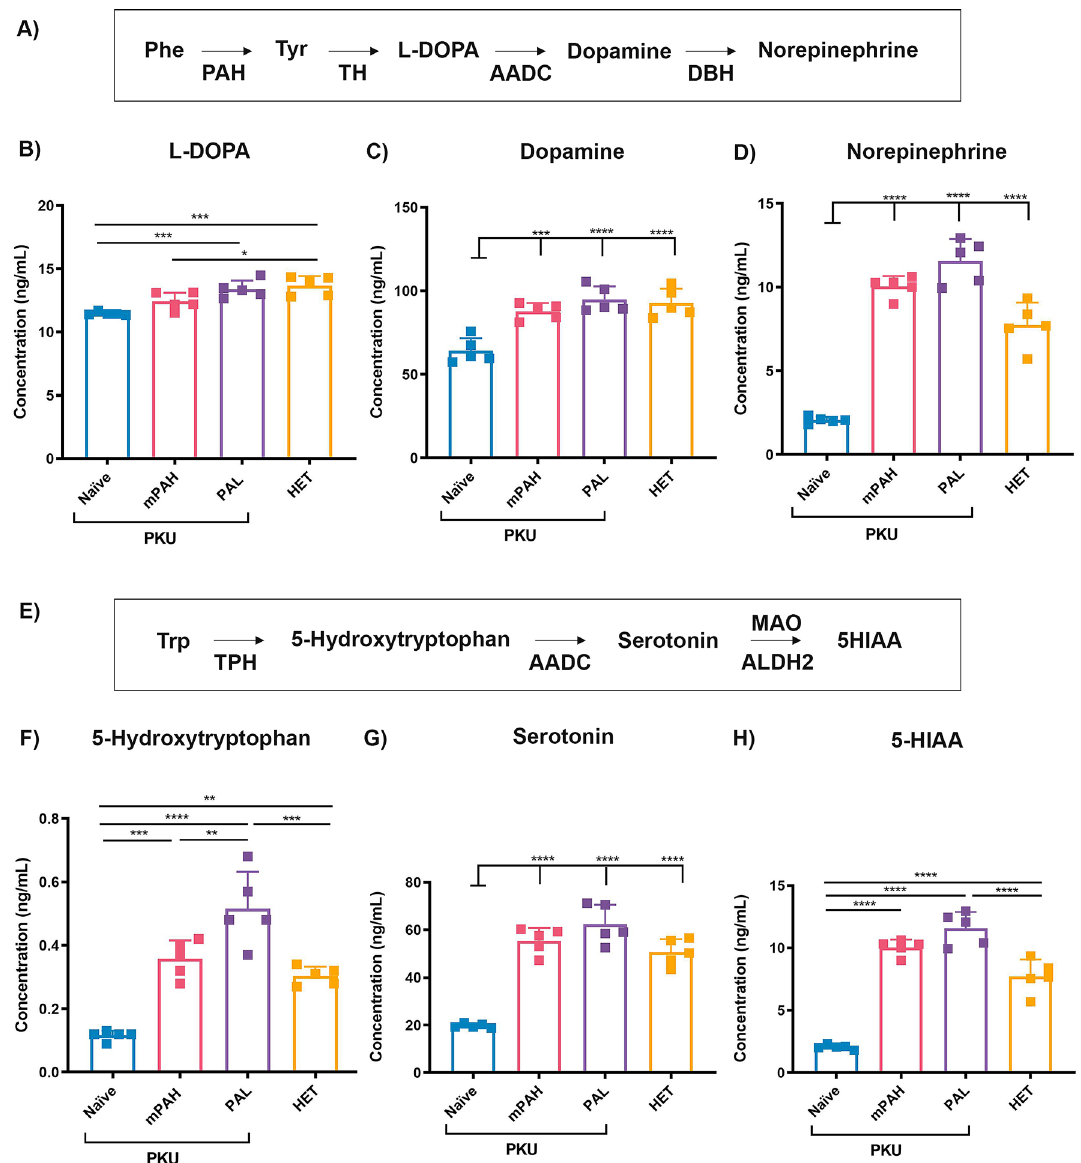
Figure 3. Restoration of brain neurotransmitter levels after PAH or PAL administration. (A) Schematic of major steps involved in synthesis of neurotransmitters dopamine and norepinephrine. ( B) Dopamine precursor L-DOPA was significantly higher in PAL PAH enu2 and HET brains as compared to the naïve PAH enu2 brains. Significant increases in (C) dopamine and (D) norepinephrine were observed in both the PAH and PAL PAH enu2 mouse brains as compared to the naïve mice. (E) Schematic of serotonin synthesis and downstream metabolite 5-hydroxyindolacetic acid (5-HIAA). Serotonin precursor 5-hydroxytryptophan (F) , serotonin (G) and 5-HIAA (H) were all restored to levels similar to HET mice after PAH and PAL administration. N = 5 per group were used for analysis. Control mice and mice treated with 1e11 vg/mouse of PAH or PAL vector were terminated on day 41 and perfused with PBS. Group abbreviations: PKU naïve, untreated PAH enu2 mice; PKU PAH or PAL, treated PAH enu2 mice; HET, untreated HET mice. One-way ANOVA Tukey’s multiple comparison, *p < 0.05, **p < 0.01, ***p < 0.001 and ****p < tion of RXR function, (downstream function of this pathway is lipid and xenobiotic metabolism), xenobiotic metabolism PXR signaling and glutathione mediated detoxification among the top affected pathways (Fig. 6B). The expression of top three proteins in each of these affected pathways is shown in Supplementary Fig. S4A–C). All these proteins were upregulated in PAH enu2 mice and either normalized or trending towards normalization post PAH and PAL treatment. We also observed modest changes in various proteins involved in cholesterol biosynthesis (Supplementary Fig. S4D) consistent with the gene expression results above. Next, we performed a network analysis to understand the interaction between the differentially expressed proteins in our data set. This analysis assumes that highly connected networks are biologically significant. The network with highest score was lipid metabolism suggesting that the greatest number of differentially expressed proteins in the liver of PAH enu2